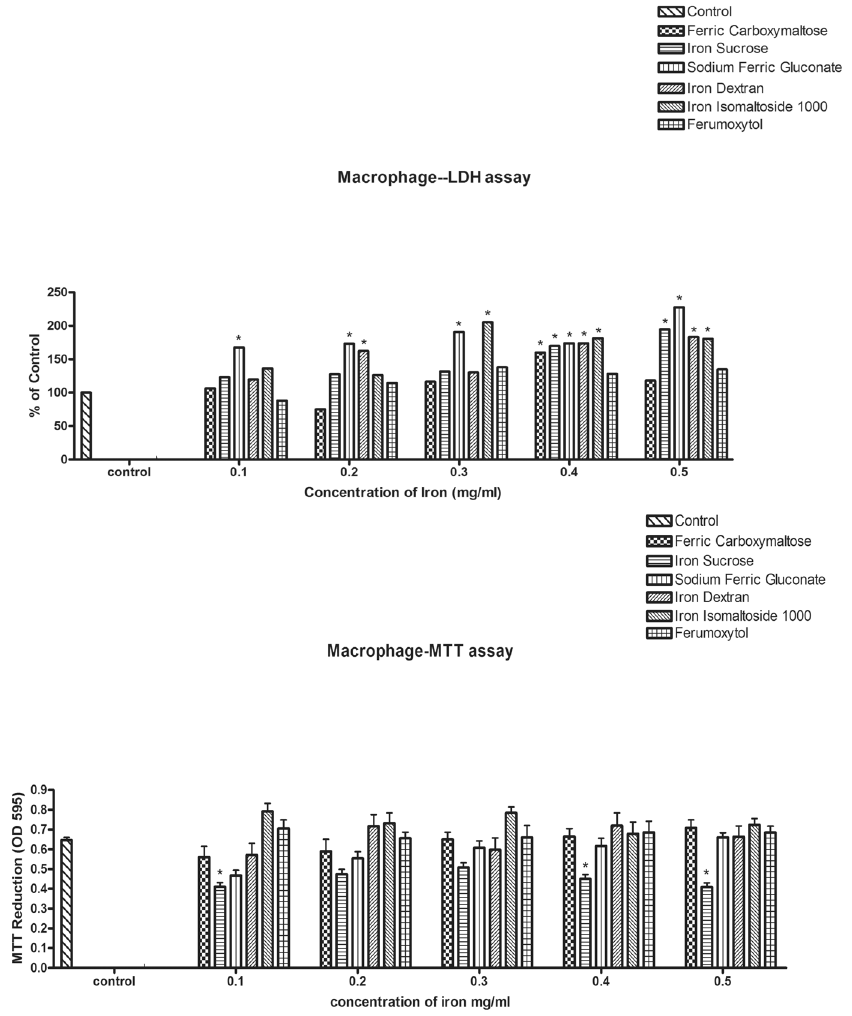
concentrations of iron compounds for 24 hours. Lactate dehydrogenase activity in media and in cell lysates was measured (top figure, A). In a separate experiment the MTT substrate was added to the media during the last four hours (bottom figure, B). Results are means ± SEM of three experiments, each conducted in triplicate. Data represents the mean ± SEM from three independent experiments and are compared to control for statistical significance using ANOVA and post-hoc testing. * p <